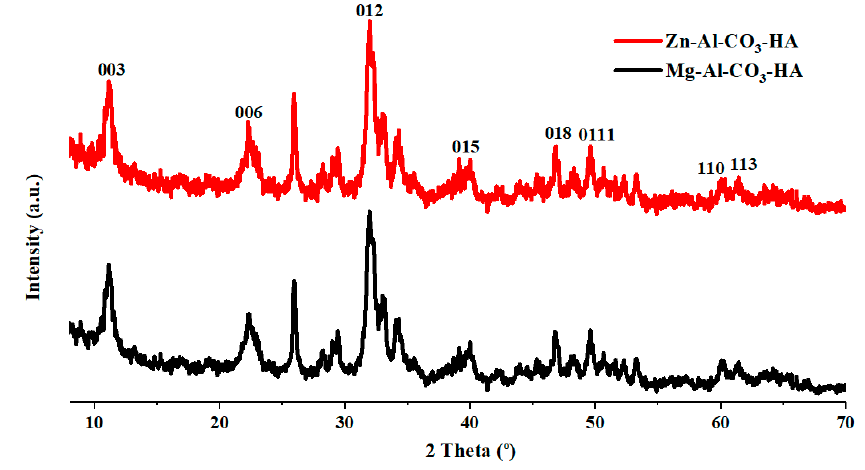
Figure 1. FTIR spectra of Zn-Al-CO 3 -hydroxyapatite (HA) and Mg-Al-CO 3 -HA layered double hydroxide (LDHs).